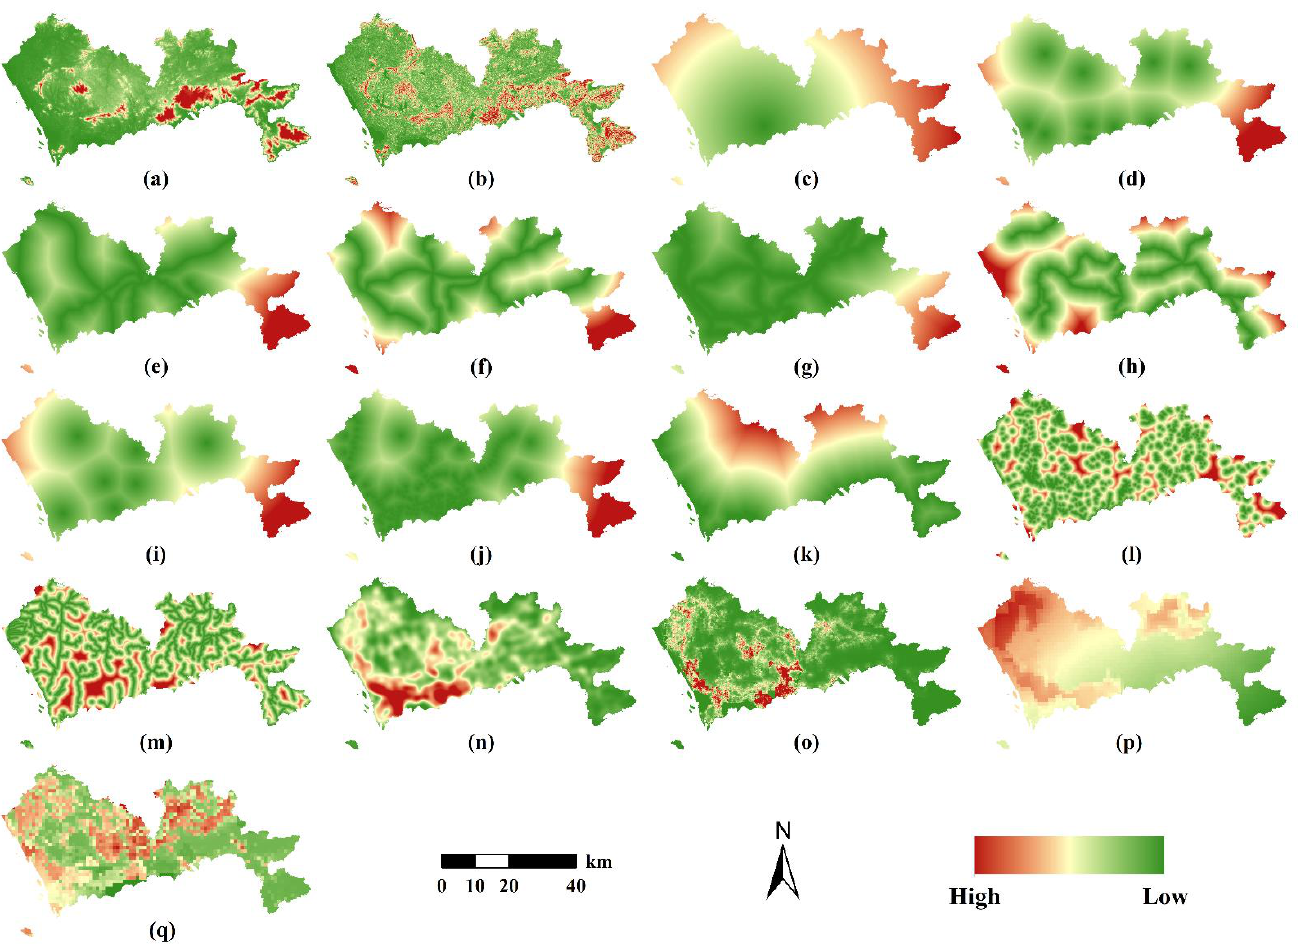
Figure 4. Driving factors of urban land use change in Shenzhen. ( a ) DEM; ( b ) slope; ( c ) distance to city center; ( d ) distance to district centers; ( e ) distance to railways; ( f ) distance to highways; ( g ) distance to national roads; ( h ) distance to provincial roads; ( i ) distance to railway stations; ( j ) distance to subway stations; ( k ) distance to ocean; ( l ) distance to lakes; ( m ) distance to rivers; ( n ) density of urban road network; ( o ) population density; ( p ) PM2.5; ( q ) GDP.